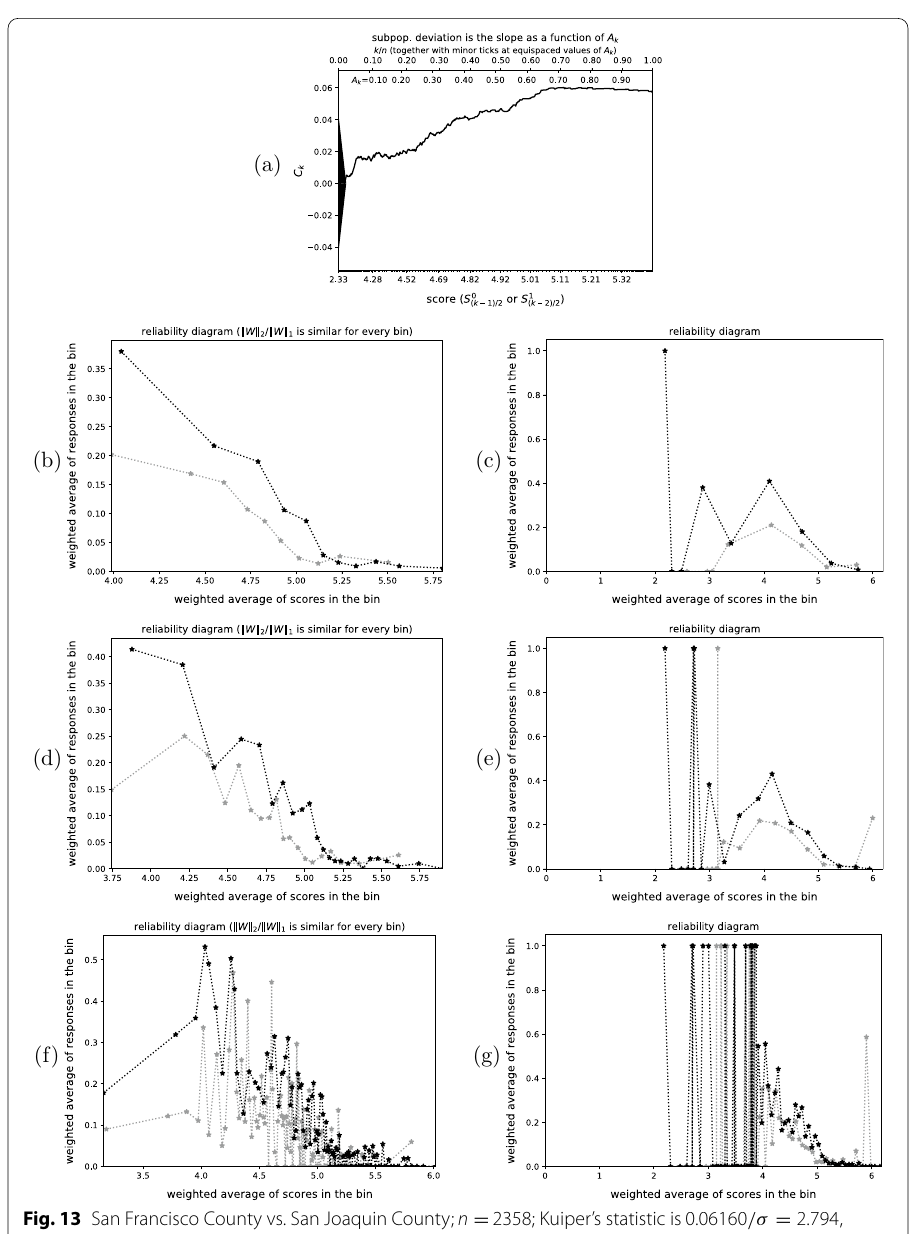
Fig. 13 San Francisco County vs. San Joaquin County; n = 2358; Kuiper’s statistic is 0.06160 /σ = 2.794 , Kolmogorov’s and Smirnov’s is 0.06025 /σ = 2.733 ; only the cumulative graph ( a ) and the otherwise extremely noisy reliability diagrams each with 100 bins ( f and g ) fully detail the sharp spike at scores just slightly greater than 4. The metrics of Kuiper and of Kolmogorov and Smirnov report some statistically significant deviation between the